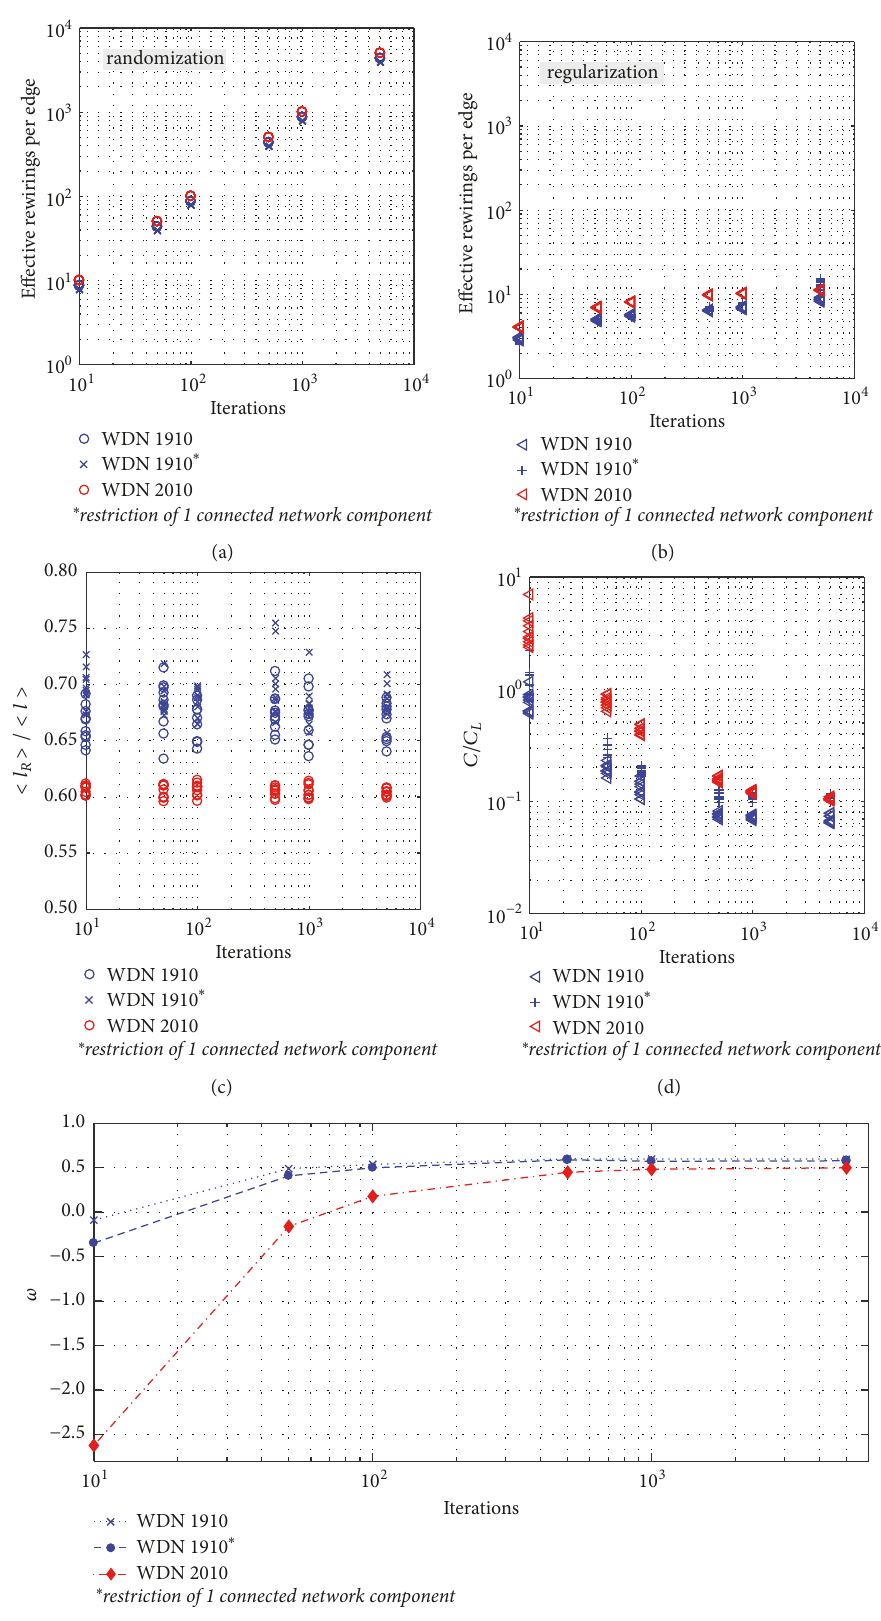
Figure 9: Convergence plots when creating the random and regular network equivalents (10 stochastic networks per iteration step) for the WDN 1910 and the WDN 2010. Effective edge rewiring in (a) the randomization process and (b) the regularization process; (c) ratio of the characteristicpathlength of therandomized and theoriginal networks; (d)ratioof the clusteringcoefficientof the original andthe regularized networks; and (e) the convergence of the small-world property 𝜔 . For further analysis the number of iterations was set to 10 1 and 10 3 for the randomization and regularization process,